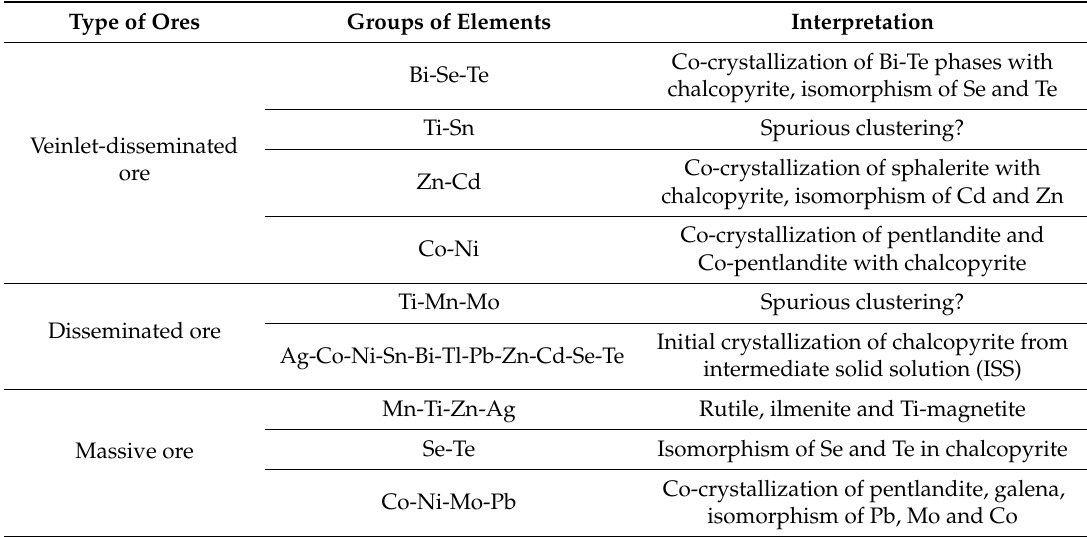
Figure 7. Suggested classification tree. Colors are chosen arbitrary to match the colors of ore types in Figure 1b. Table 1. Results and interpretation of element clustering.